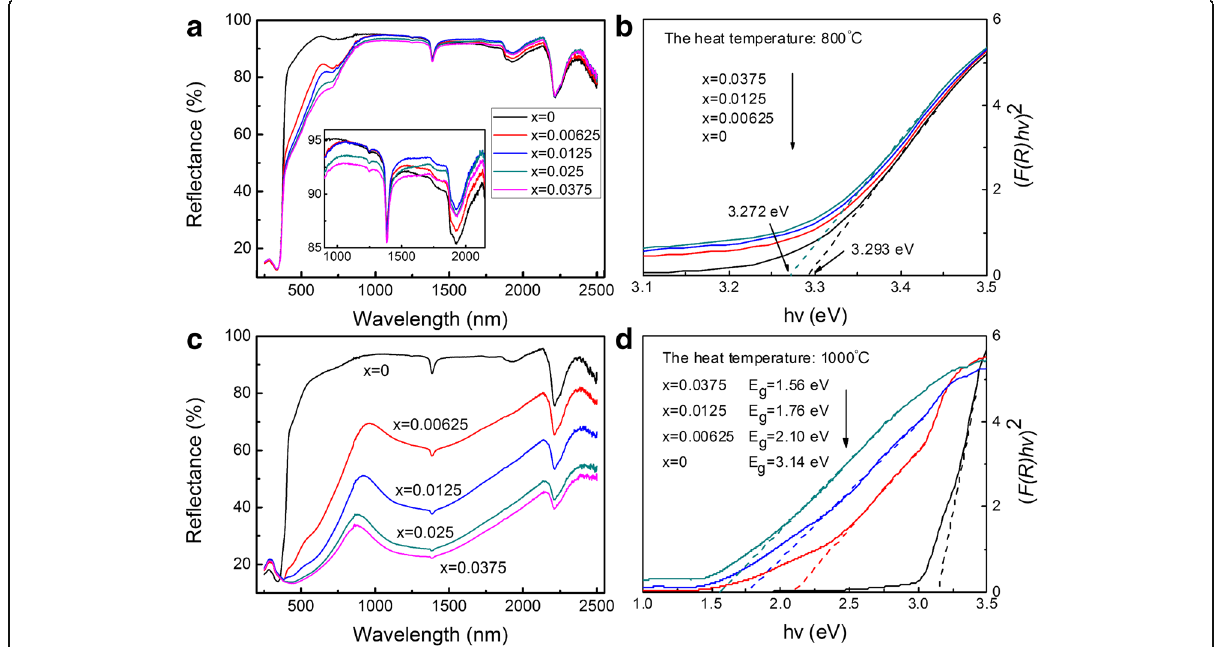
Fig. 5 The UV-VIS-NIR diffuse reflectance spectra and E g of Ti 1 − x Cr x O 2 samples with different sintering temperatures and Cr concentrations ( a , c the raw data; b , d Kubelka-Munk transformed reflectance spectra)